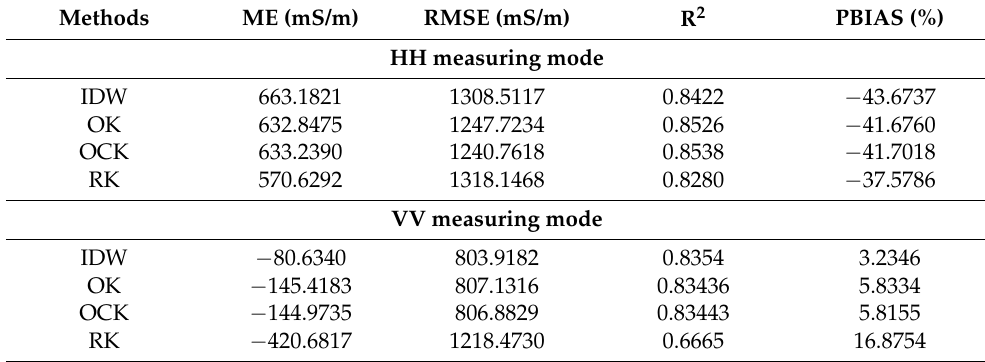
Table 16. Comparison of model performance from four interpolated methods of two measuring modes for soil salinity prediction.